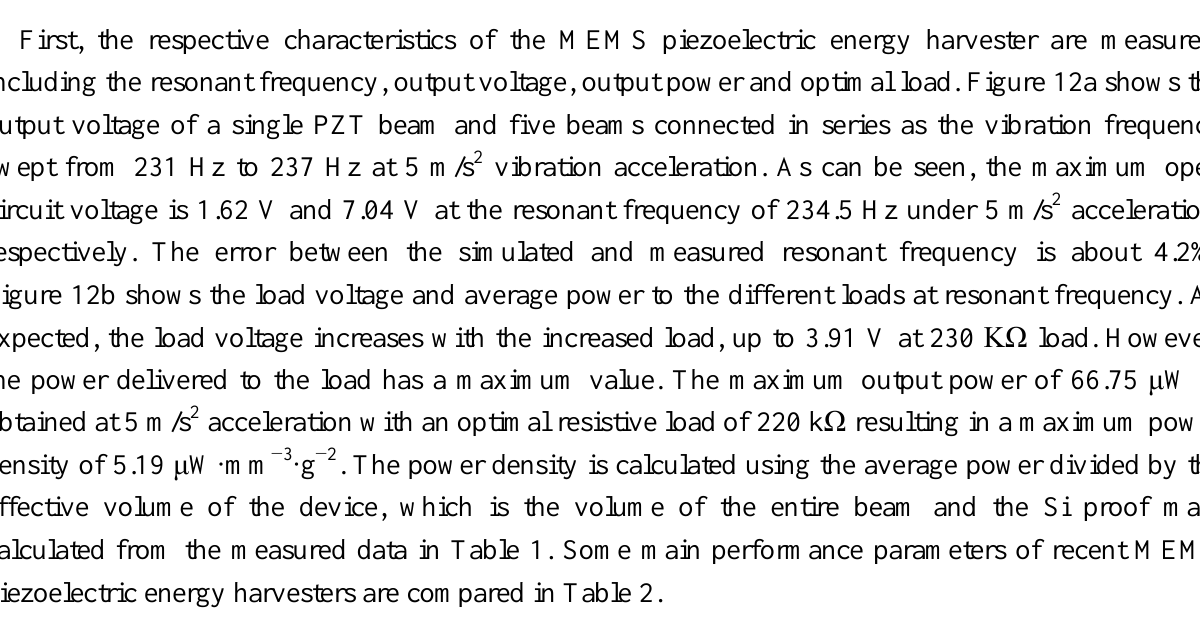
Figure 12. The characteristics of MEMS piezoelectric energy harvester. ( a ) Open circuit voltage vs. the frequency. ( b ) Load voltage and power vs . the load.